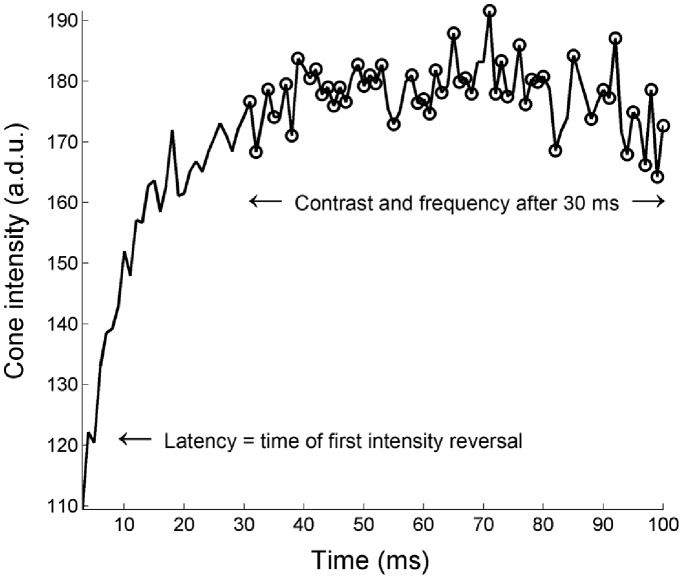
Representative data to illustrate measurement of intensity fluctuations.Latency was defined as the time at which a negative slope in the cone intensity trace was first detected. Contrast was determined by the coefficient of variation beyond 30) counting extrema beyond 30 ms, and b) wavelet analysis beyond 30 ms.